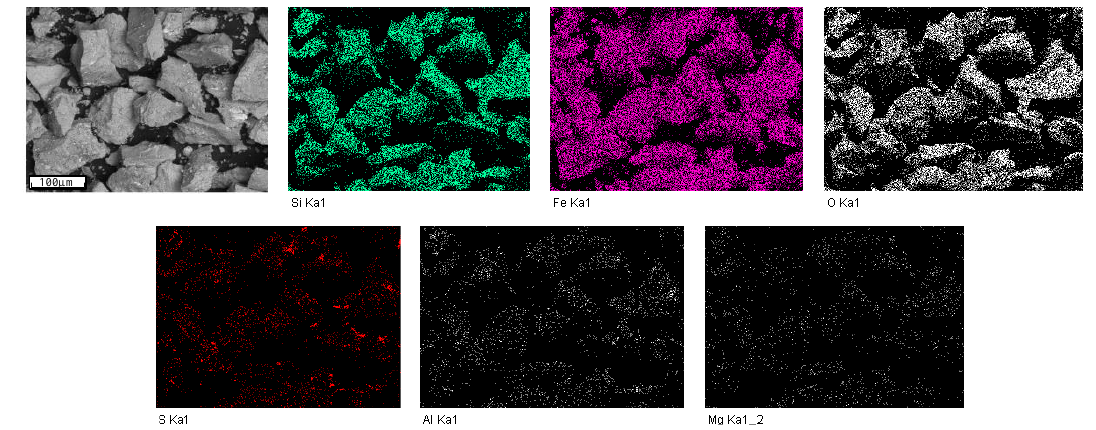
Figure 2. Scanning electron microscopy (SEM) image and elemental map of nickel slag samples.